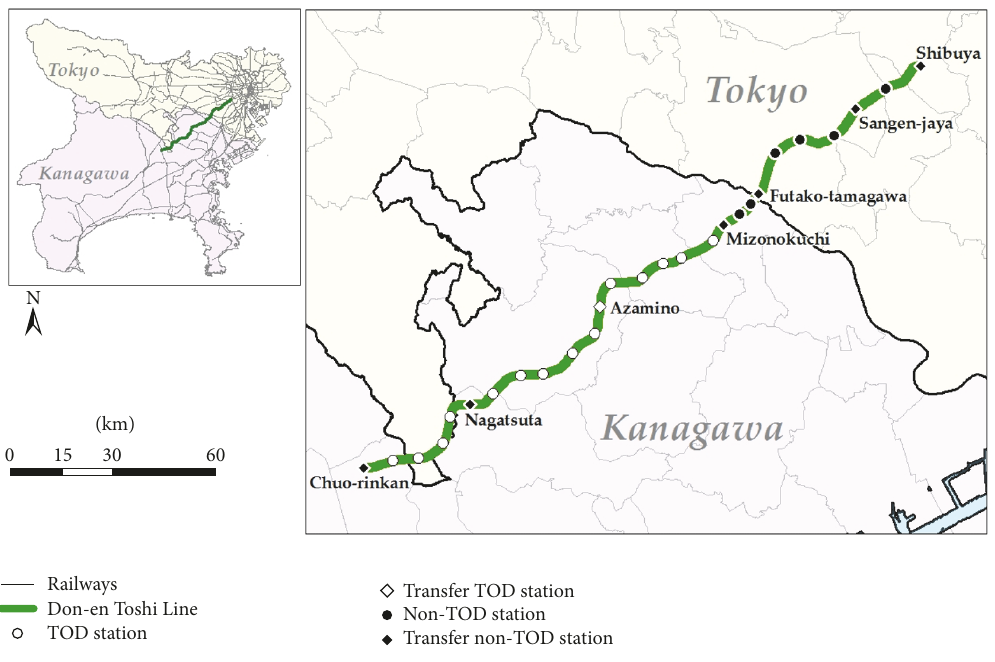
Figure 1: Tokyu Den-en Toshi